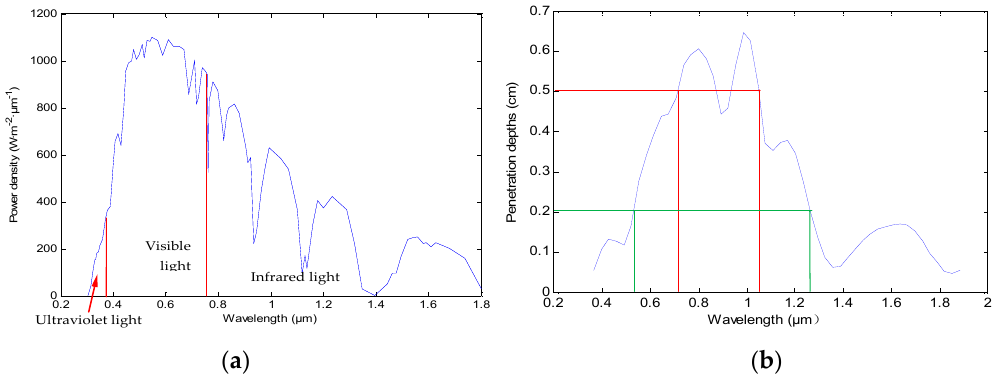
Figure 2. ( a ) The curve of power density of the earth surface; ( b ) The penetration depths in skin tissue of the light corresponding to 0.40–1.80 μ m.